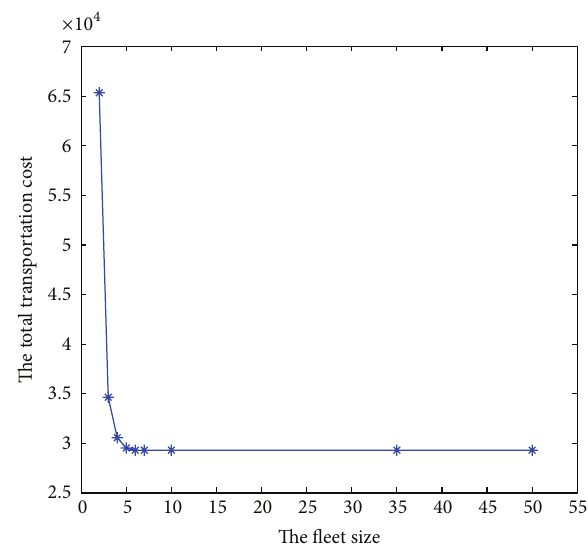
Figure 5: The trade-off relationship between fleet size and total transportation